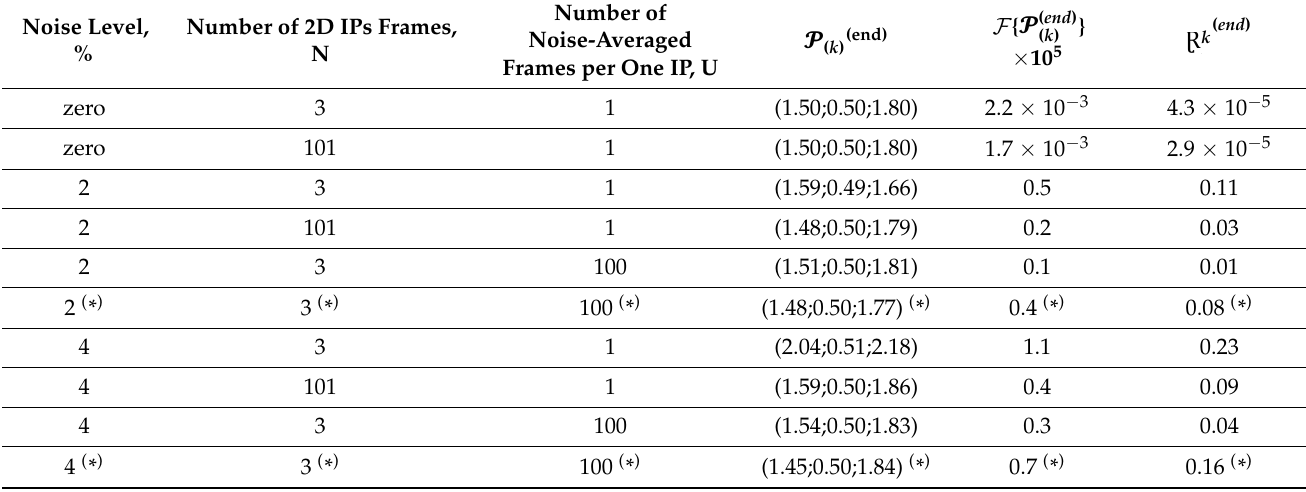
Figure 3. The 2D IPs: no- noise level (left), 4% -noise level (middle) and de-noised (right). The number of non-averaged IPs data frames is equal to 100. The sample rotation angles Φ are equal to {−20°, 0°, 20°}, respectively. Table 1. The Coulomb-type point defect in crystal Si(111). The sample rotation angles Φ i are in the range ( − 20 ◦ , 20 ◦ ). The true vector dimensionless coordinates ( X , Y , Z ) are equal to 61 × 61 × 21. The case of the Poisson-noise with the levels of 2% and 4% are considered. Note bene: Data in the two lines marked with asterisk ( * ) relate to the XRDT recovery processing by means of using the geometric means of the single 2D Poisson-noise IPs data frames.